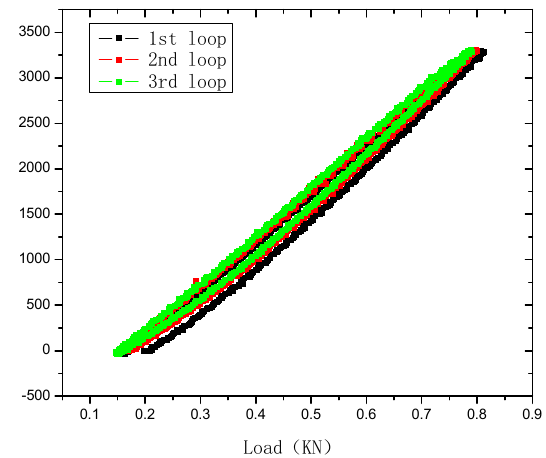
Figure 10. Strain-load relationship of PP-OFBG